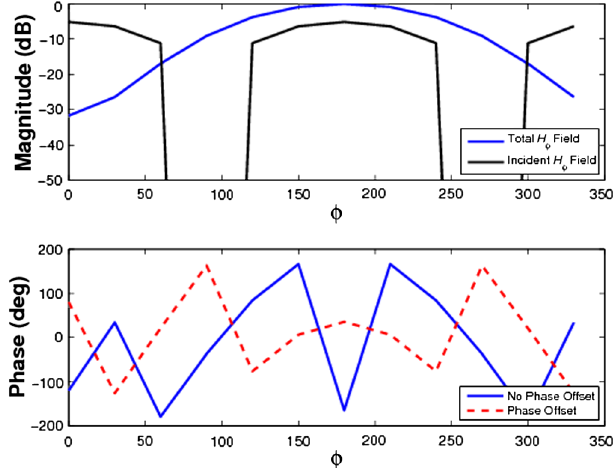
FIG. 13. The tangential magnetic field H ’ (magnitude and phase) at the boundary of a PEC cylinder when illuminated with a plane wave (blue line). The black line in the upper plot is the magnitude of the magnetic field of the incident plane wave when compared to the magnitude of the total magnetic field at the boundary. The red dashed line in the lower plot is the change in phase for a constant 200 (cid:3) phase